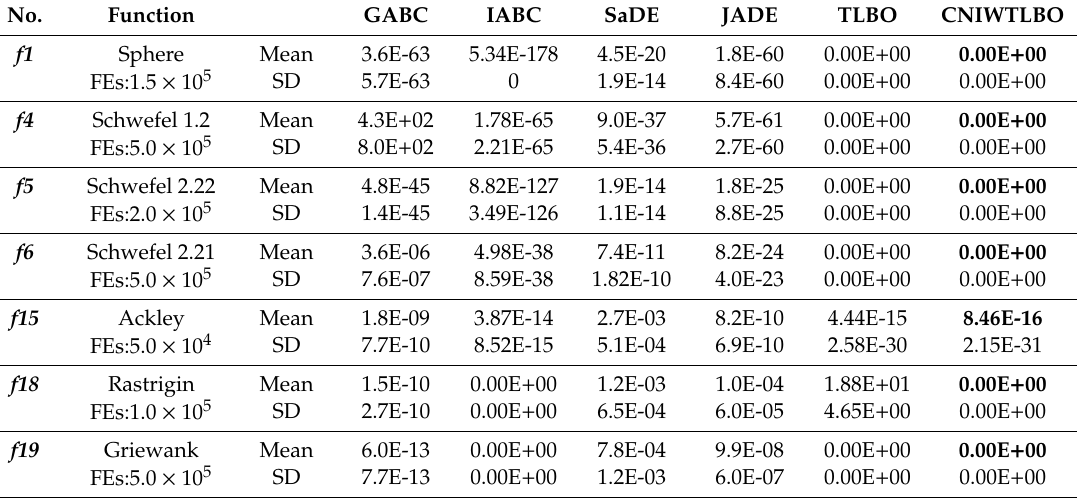
Table 6. Comparative results of CNIWTLBO and the variants of ABC,